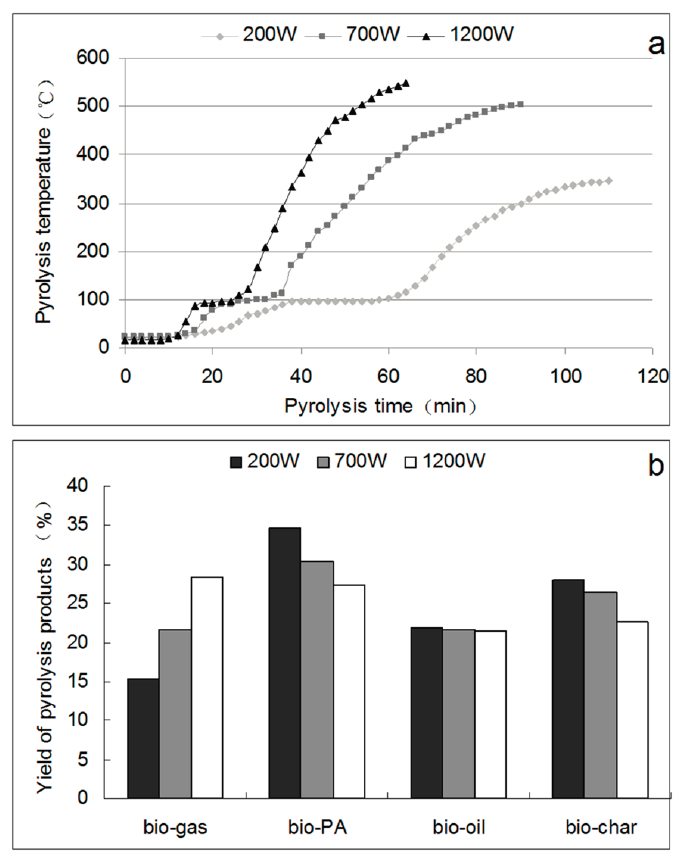
Figure 1. Pyrolysis curves ( a ) and the yields of pyrolysis products ( b ) generated with different heating